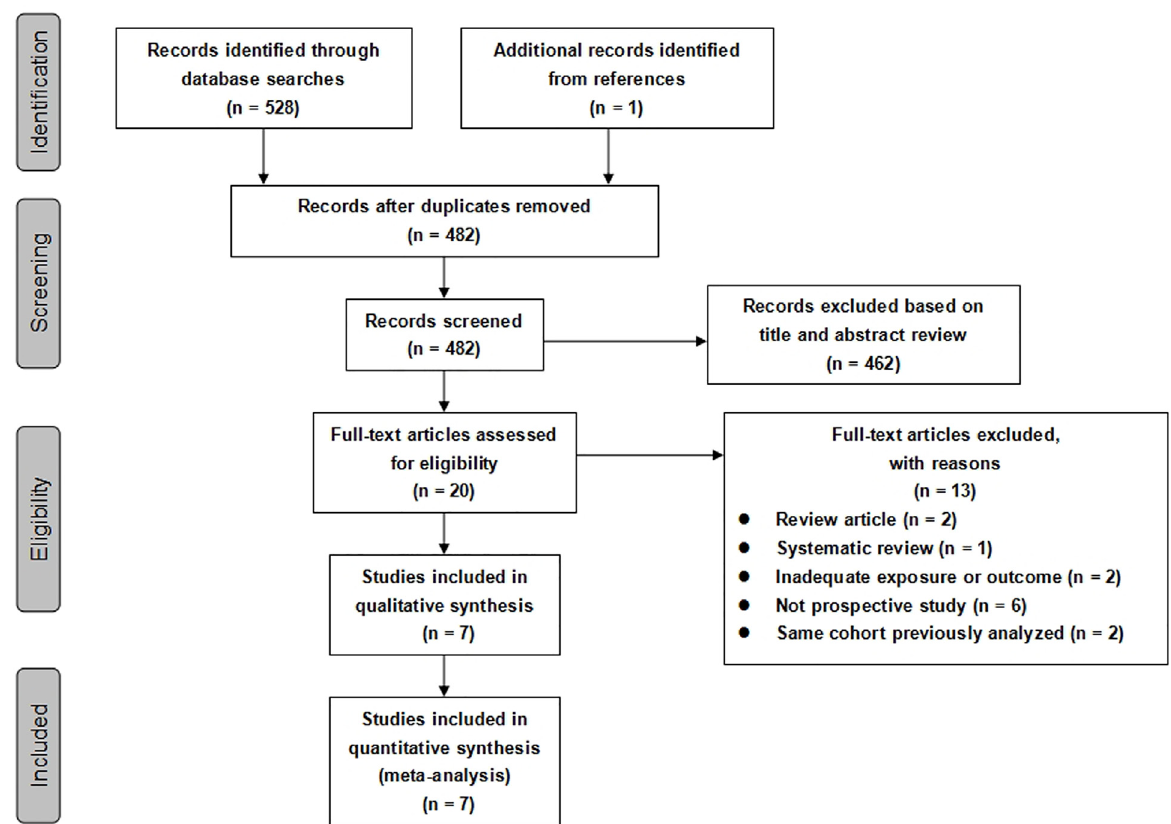
Fig 1. Flow chart for selection of articles included in the